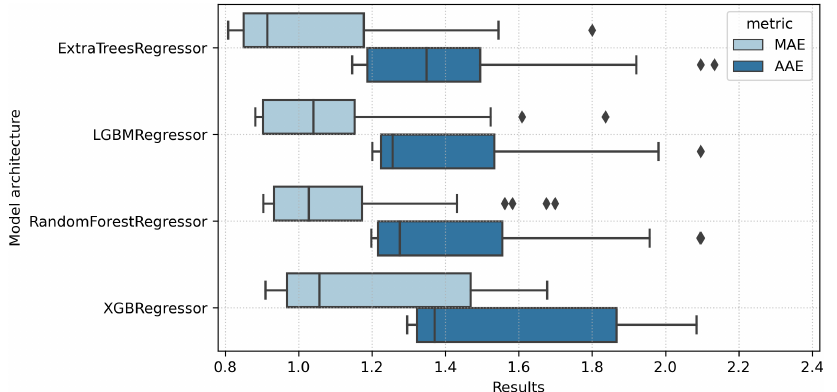
Figure 3. Different model architecture performance comparisons for all tested feature configurations.